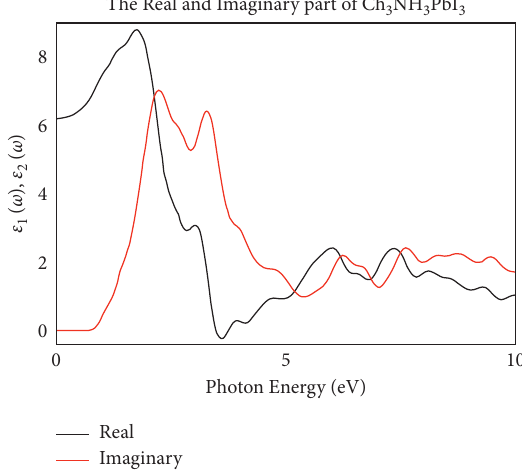
Figure 4: Real ε